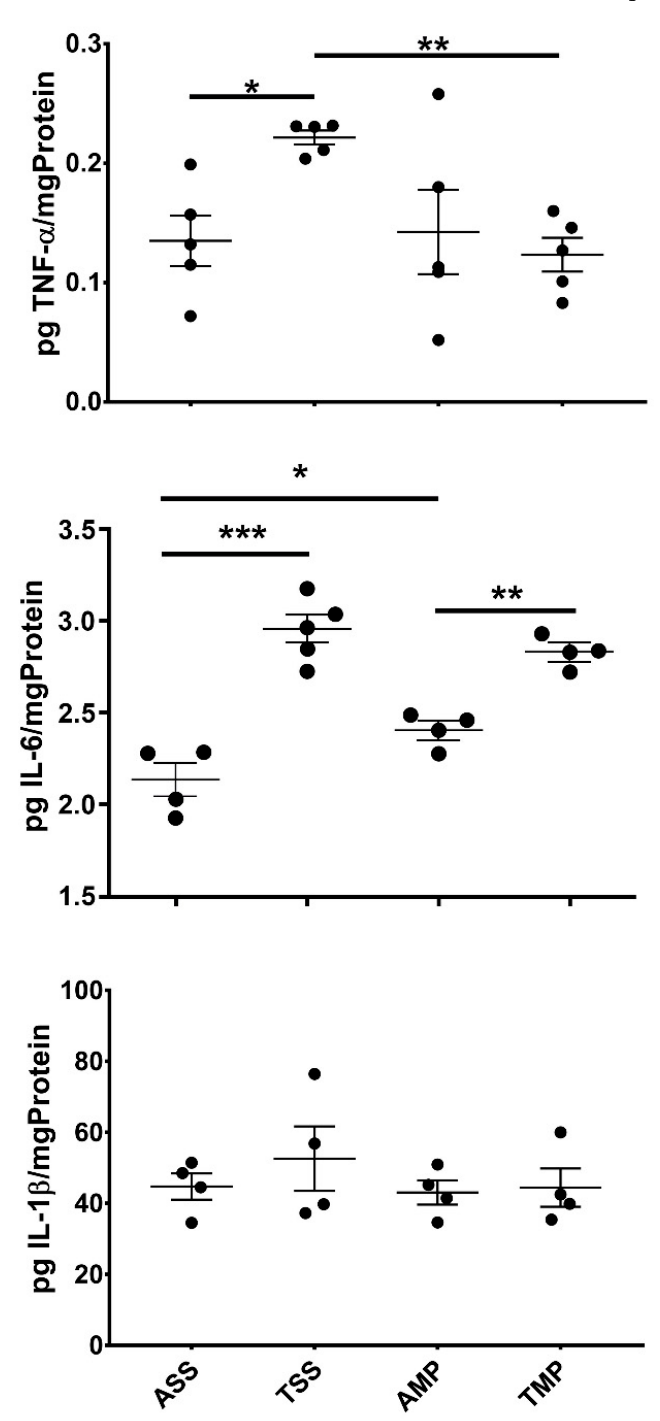
Figure 2. Central cytokine levels (pg/mg protein) in soluble extract from brain of mice chronically exposed to toluene and analyzed by ELISAs test. All results are showed as the mean ± standard error of groups values. * p < 0.05, ** p < 0.01, *** p < 0.001. ANOVA followed by Tukey’s test was performed. Air + saline solution (ASS); toluene + saline solution (TSS); air + methylprednisolone (AMP); toluene + methylprednisolone (TMP).